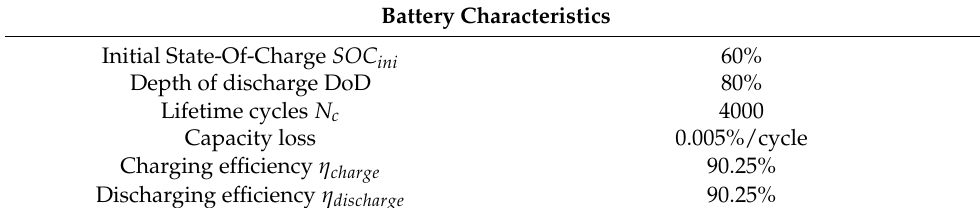
Table 2. Battery characteristics.